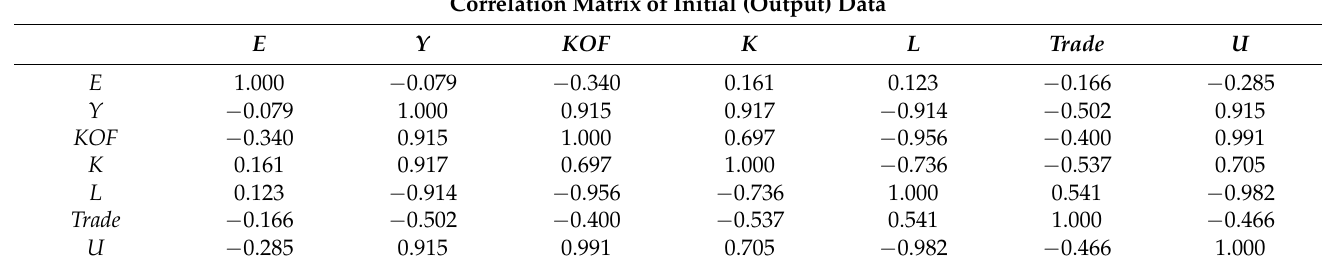
Table 2. Cont. Correlation Matrix of Initial (Output)